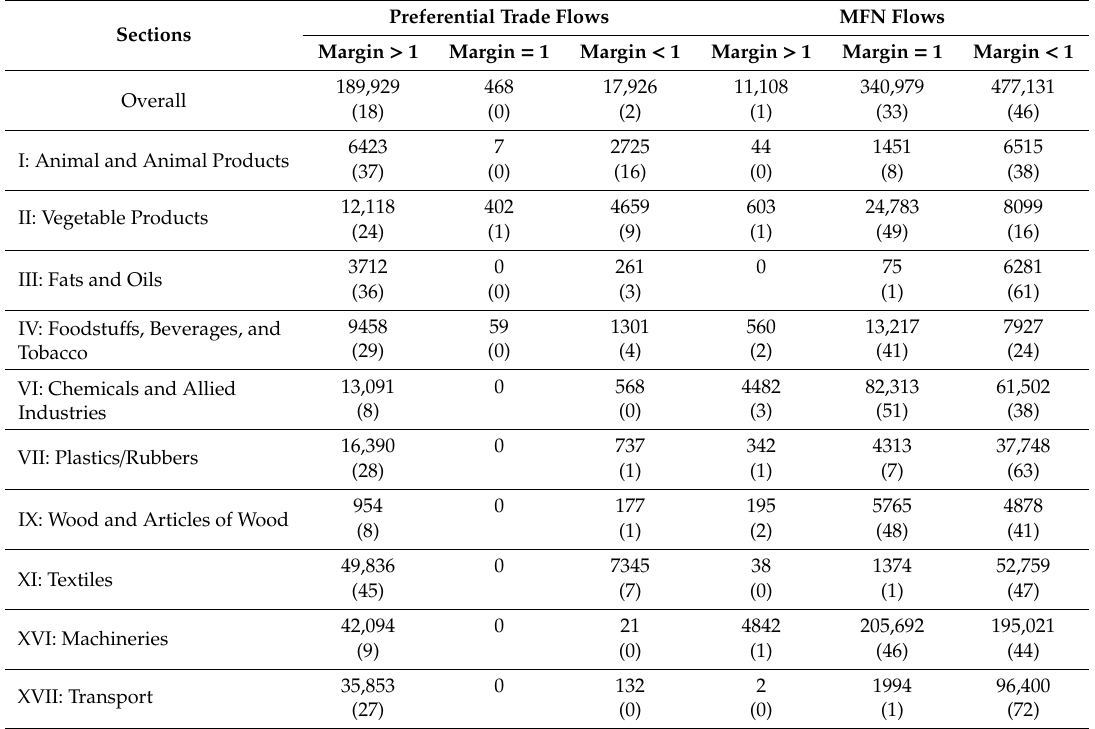
Table 2. Trade flows based on the CES tari ff margins, preferential status, and shares with respect to total EU